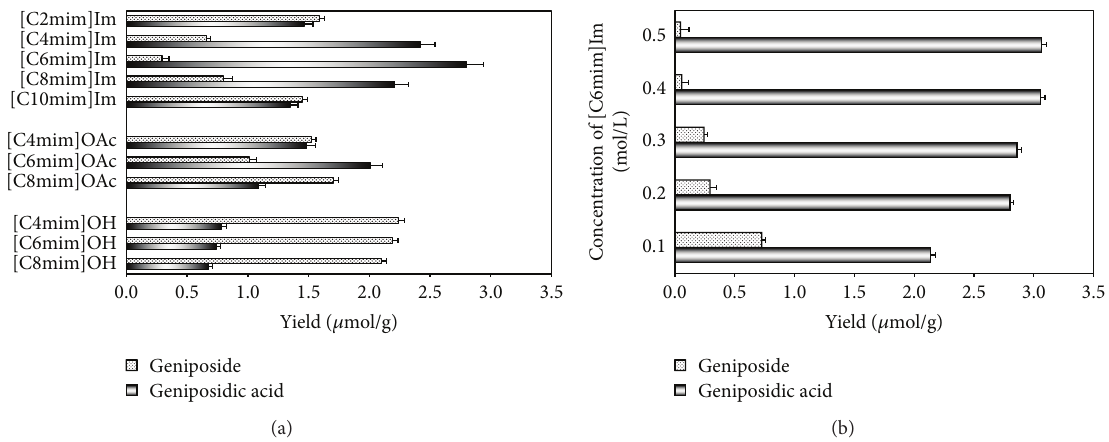
Figure 2: Effects of different ionic liquids (a) and their concentration (b) on the yield of geniposidic acid from E. ulmoides bark.